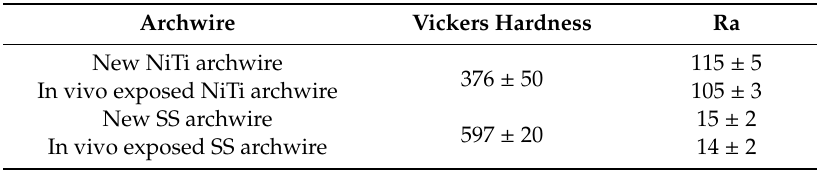
Table 1. Vickers hardness values (VHV) and roughness (Ra in nm) on NiTi and SS